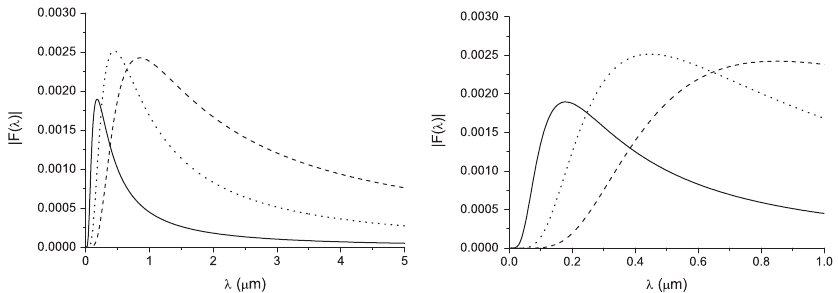
FIG. 6. Ensemble average modulus of the bunch form factor versus wavelength for SASE1 afterburner, and an enlarged fraction of this plot, for the R 56 of the dispersion section equal to 50 (cid:4) m (solid), 200 (cid:4) m (dotted), and 500 (cid:4) m (dashed).